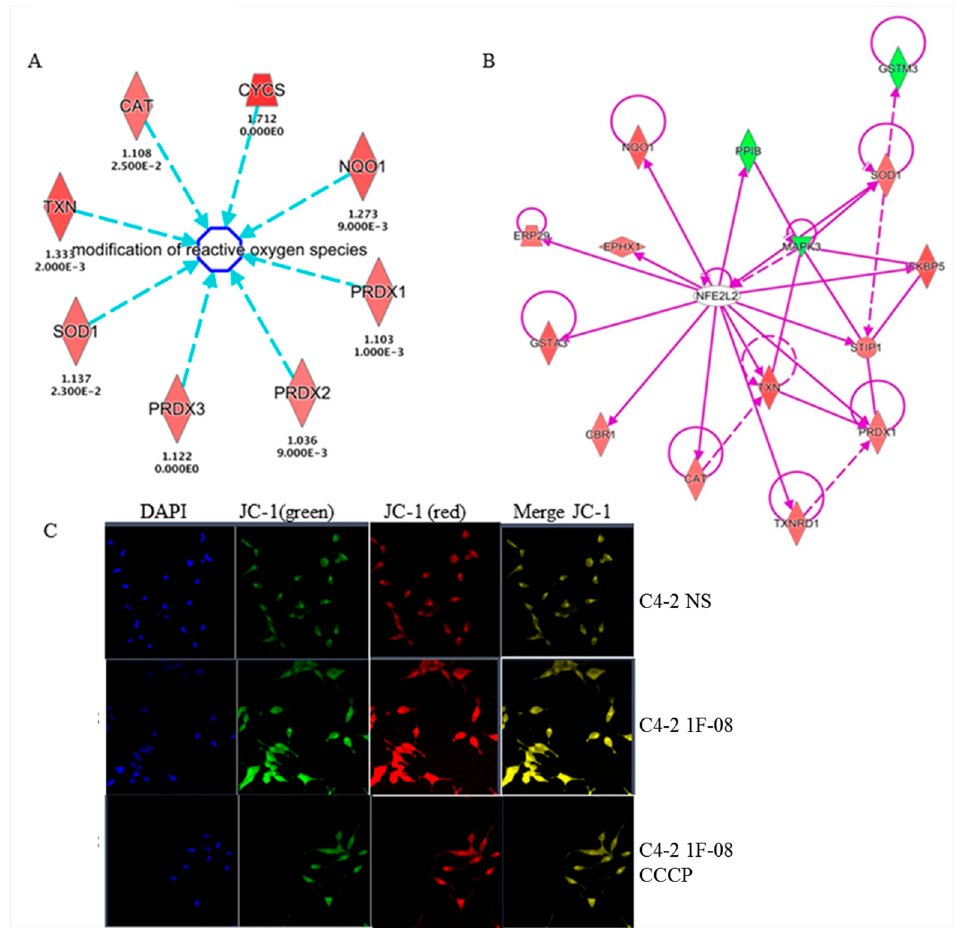
Figure 4. PXDN regulates oxidative stress pathways and decreases mitochondrial membrane potential. C4-2 NS or C4-2 1F-08 cells were subjected to proteomic analysis followed by ingenuity pathway analysis (IPA). ( A ) Several enzymes involved in modification of ROS were identified. Red denotes upregulated proteins following PXDN knockdown. Arrow tip towards ROS indicates upstream and regulating ROS. Blue dotted lines indicate an indirect relationship. ( B ) One key pathway predicted to be regulated was the Nrf2/NFE2L2 pathway. Purple solid lines indicate direct relationship, while dotted lines indicate an indirect relationship. Lines without arrows indicate binding. ( C ) Cells were stained with JC-1 dye to examine mitochondrial membrane potential; CCCP1 was utilized as a mitochondrial uncoupler control. Images were taken at 20×. JC-1 exists either as a green-fluorescent monomer at depolarized membrane potentials or as a red-fluorescent J-aggregate at hyperpolarized membrane potentials. Data are representative of at least 3 independent experiments.